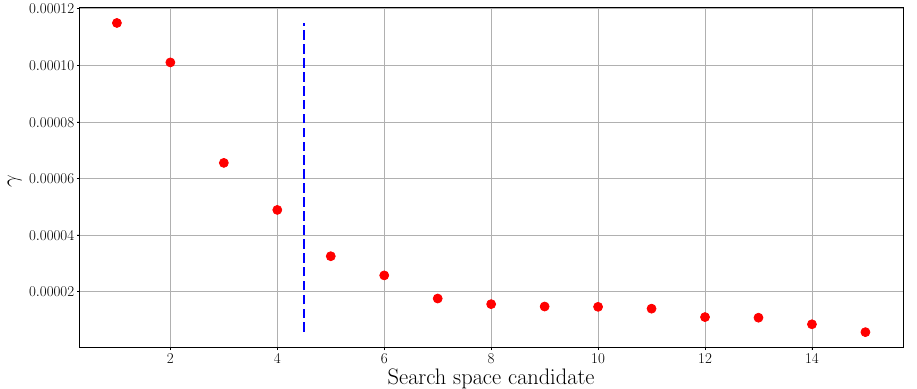
Figure 6. An example of determining the search space of the number of clusters. The dataset used here includes ethanol and